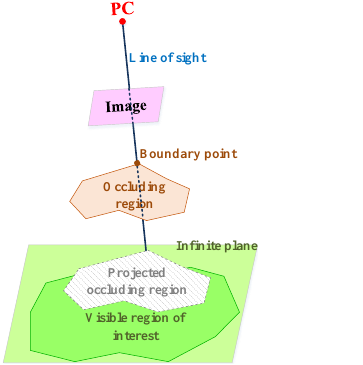
Figure 5. Identification of the occluded part of the region of interest (projection of boundary points of the occluding region onto the region of interest’s infinite plane) In the second case, where the region of interest is occluding another region, two different situations may happen: 1. All the boundary points of the region of interest are projected inside the occluded region (Figure 6.a). 2. A portion of the boundary points of the region of interest are projected inside the occluded region (Figure 6.b).